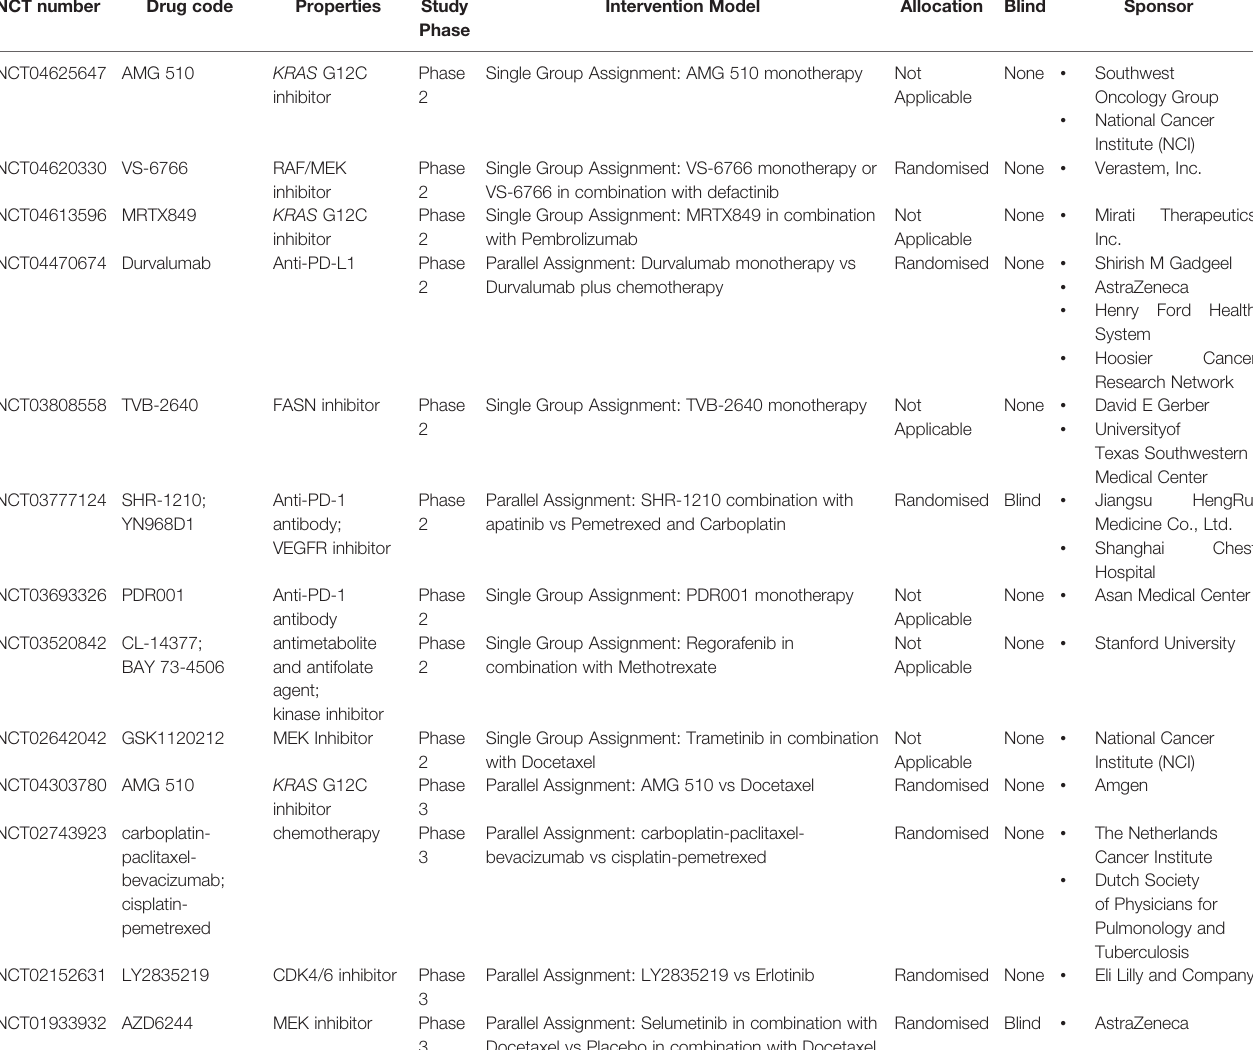
TABLE 1 | Ongoing Clinical Trials of KRAS-Mutant Lung Cancer. NCT number Drug code